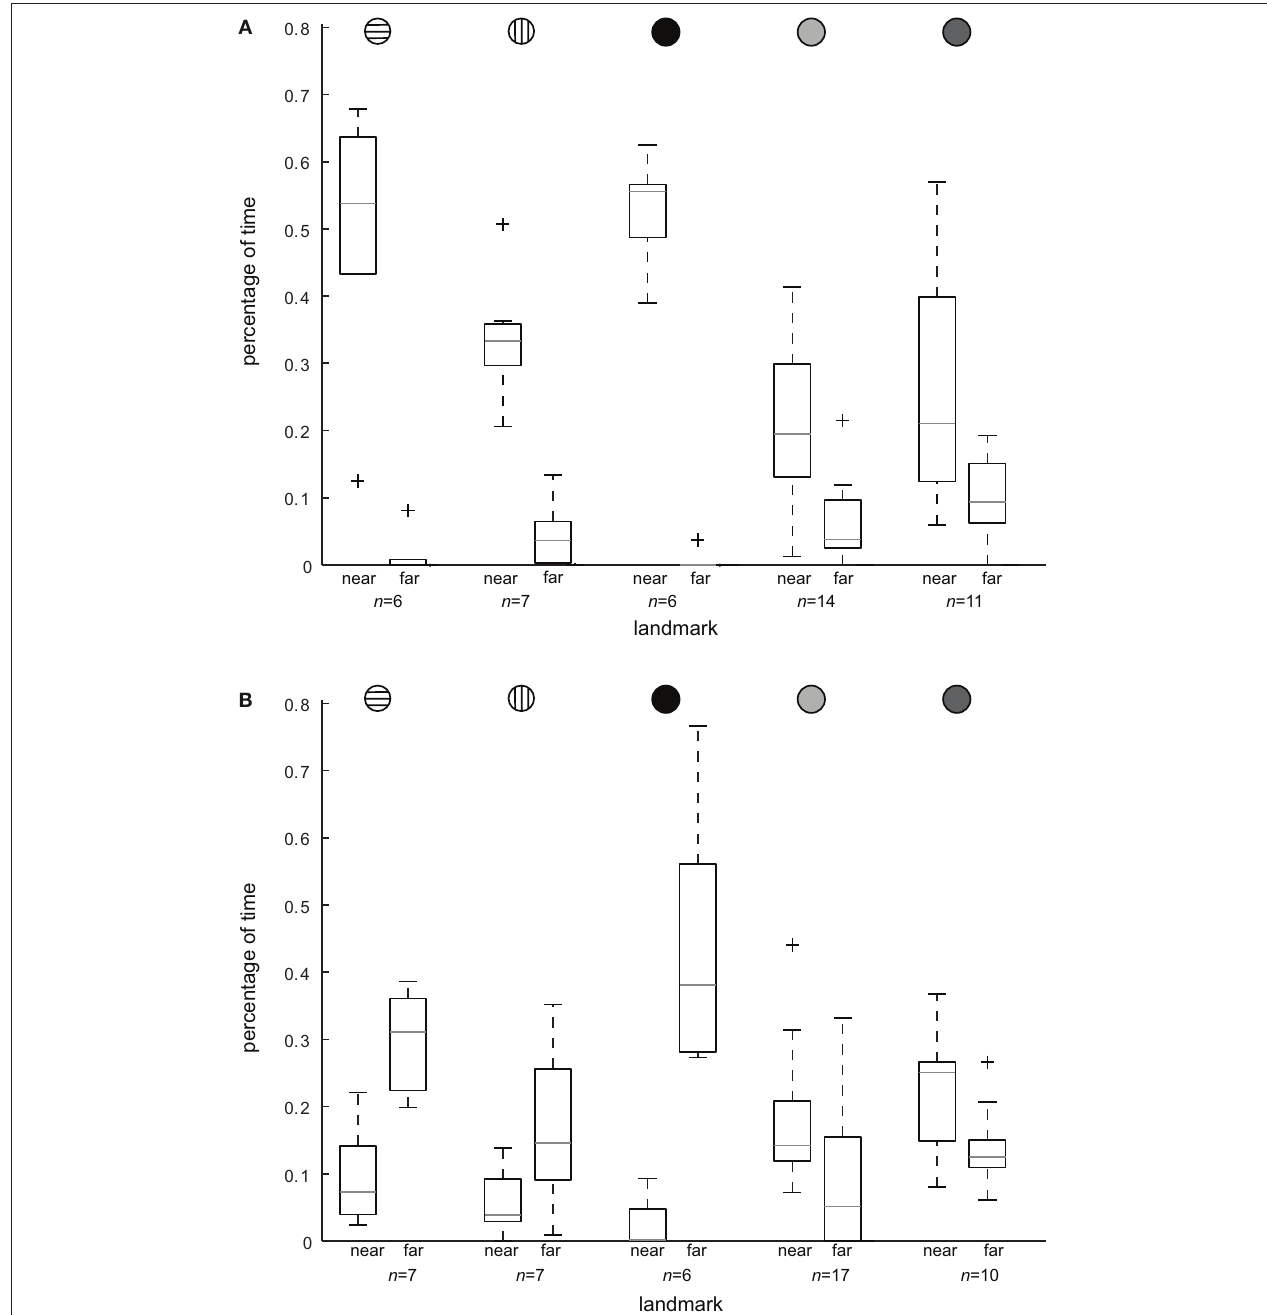
random dot pattern [ n (C) = 11, N (C) = 10; n (CF) = 10, N (CF) = 10]. The search times close to the near and the far landmark are significantly different for all textures in [ (A) , p < 0.05, Wilcoxon rank-sum test]. With the label texture swapped, bees spent significantly more time searching close to the far landmark than close to the near landmark when the label is homogeneous red or horizontal stripes ( p < 0.05, Wilcoxon rank-sum test). For the vertical stripe pattern condition we find a similar tendency ( p > 0.05). With the random patterns as label textures, the bees’ search time is slightly increased close to the far landmark, but the bees keep mainly searching close to the near landmark (with the wrong label), and thus mainly search according to the spatial configuration of the three landmarks ( p < 0.05). Outliers are marked by a cross (for details see Figure